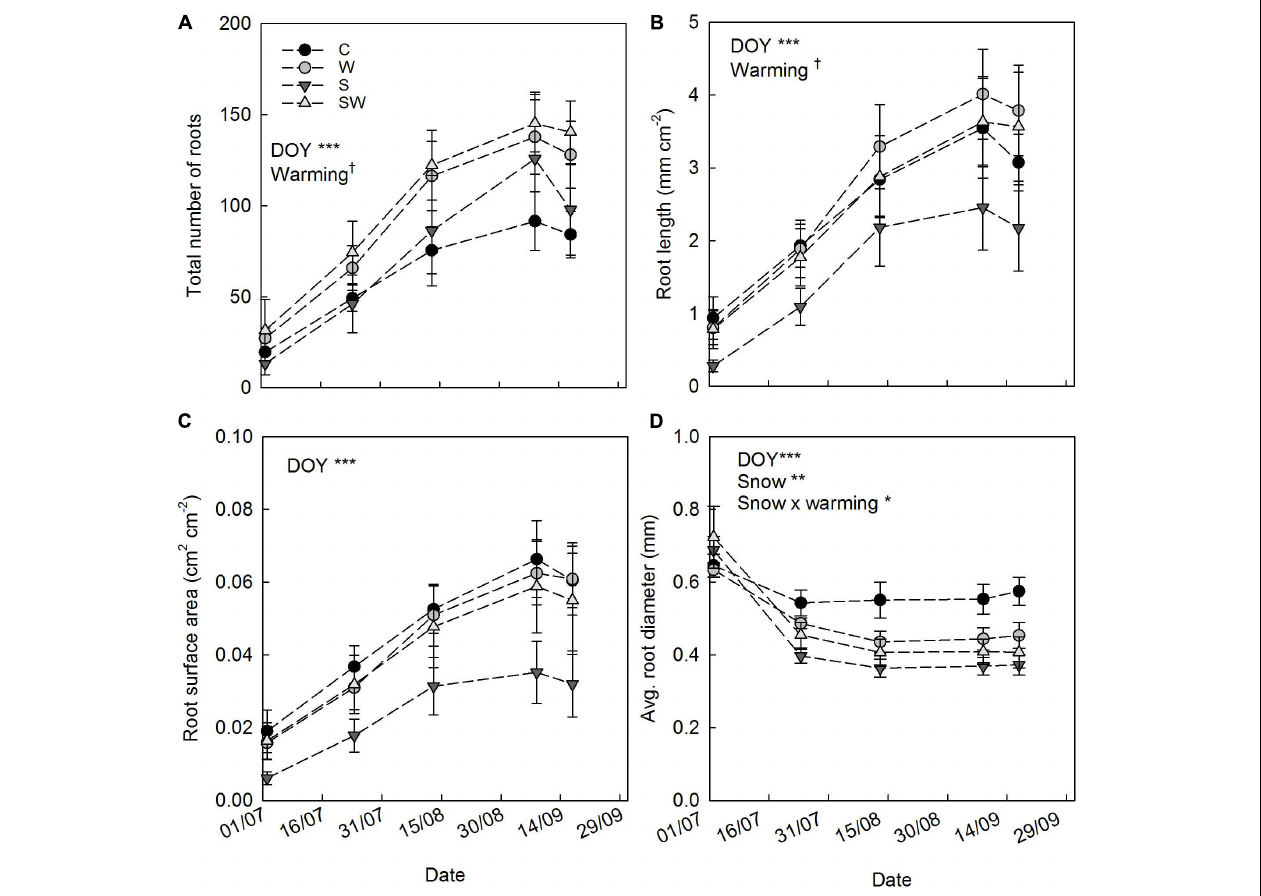
FIGURE 4 | Root parameters measured over the growing season 2014 (mean ± SE). (A) Total root number by tube. (B) Total root length per tube area. (C) Total root surface area per tube area. (D) Average root diameter by tube. Tendencies and significant repeated treatment effects are reported for each parameter and indicated by † P ≤ 0.1, ∗ P ≤ 0.05, ∗∗ P ≤ 0.01, and ∗∗∗ P ≤ 0.001. In legend: control (C), warming by OTCs (W), snow accumulation (S), and snow + warming by OTCs